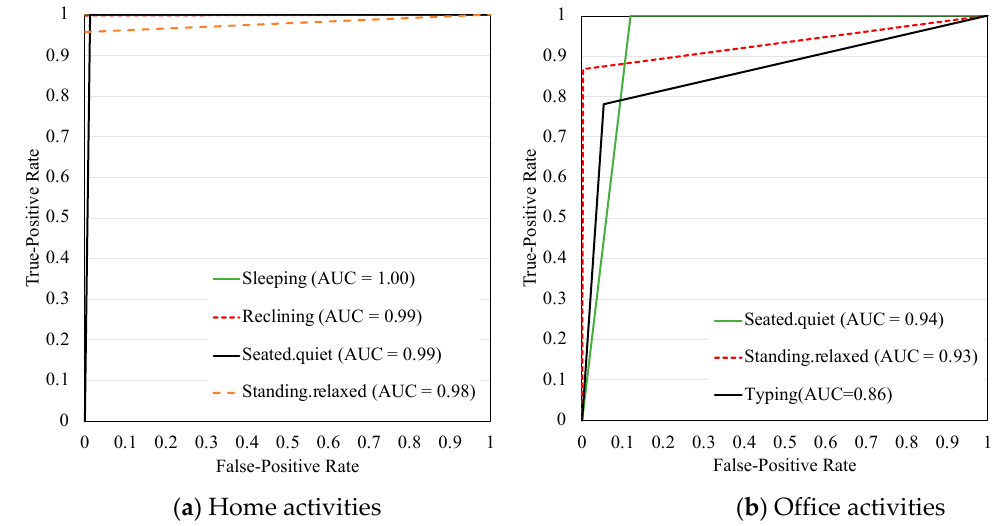
Figure 8. Receiver operating characteristic (ROC) curve for each activity.